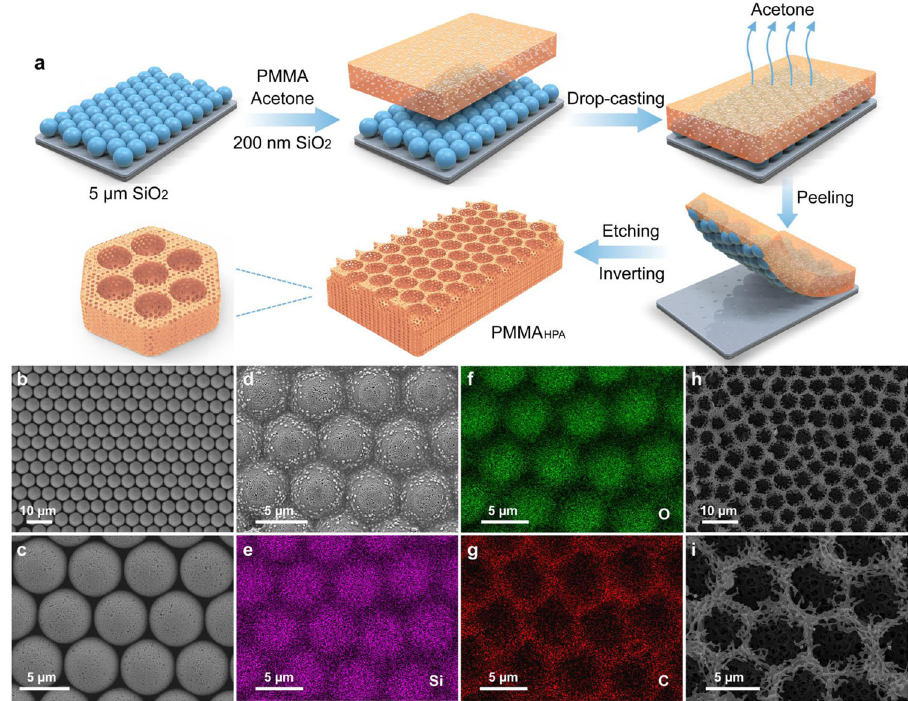
Fig. 1 Fabrication and characterization of the PMMA HPA fi lm. a Schematic illustration of the fabrication of PMMA HPA with a hierarchically porous array. b , c SEM micrographs of hexagonally close-packed monolayer SiO 2 templates. d SEM micrograph of PMMA/SiO 2 composite. e – g EDS elemental mappings of Si, O, and C in d , showing the randomly distributed SiO 2 nanospheres and regularly distributed SiO 2 microspheres of the composite. h , i SEM